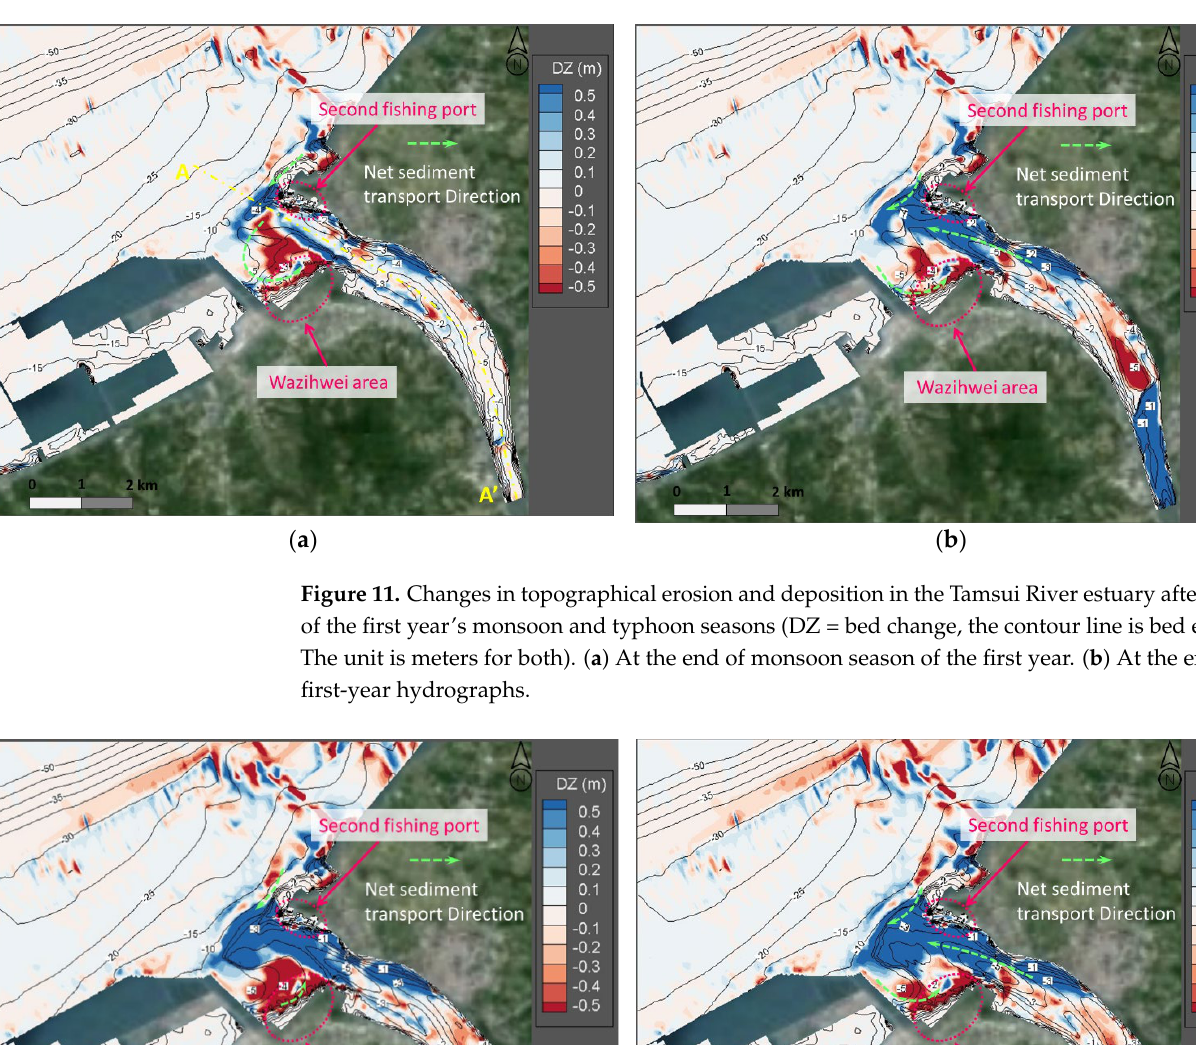
( b ) Figure 13. Changes in topographical erosion and deposition in the Tamsui River estuary after the end of monsoon and typhoon seasons in the fourth year (DZ = bed change, the contour line is bed elevation. The unit is meters for both). ( a ) At the end of monsoon season of the fourth year. ( b ) At the end of monsoon season and typhoon flood period of the fourth year.